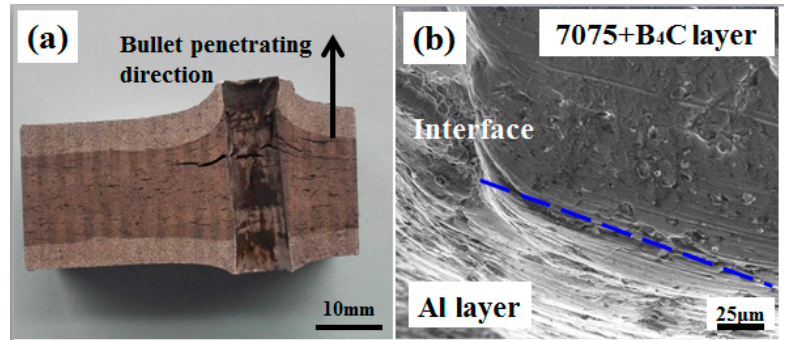
Figure 7. ( a ) Macrostructure of the BRALC ballistic trajectory and ( b ) the microstructure of the interface on the bullet crater.